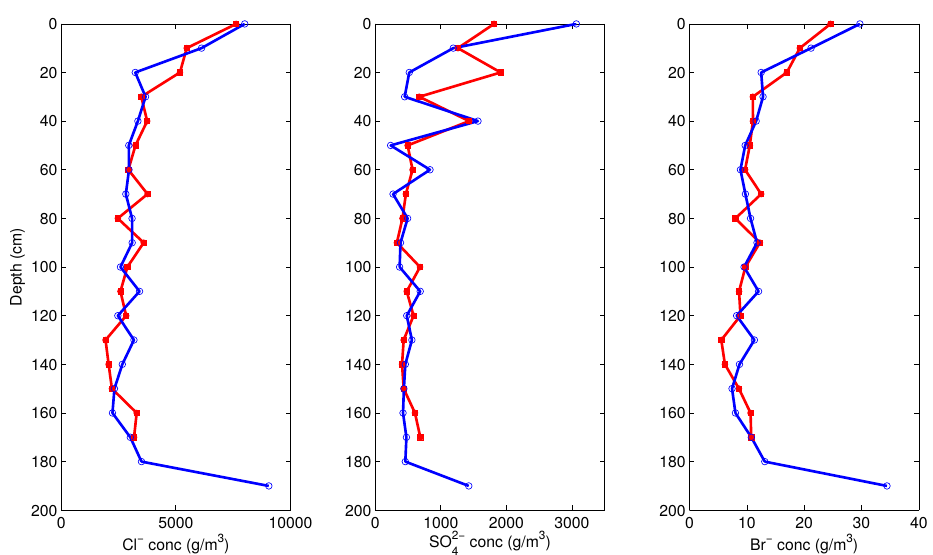
Figure 2. Anion concentrations for sea ice cores. Butter Point Site samples are shown in red filled-in squares and red lines, while Iceberg Site samples are shown in blue open circles and blue